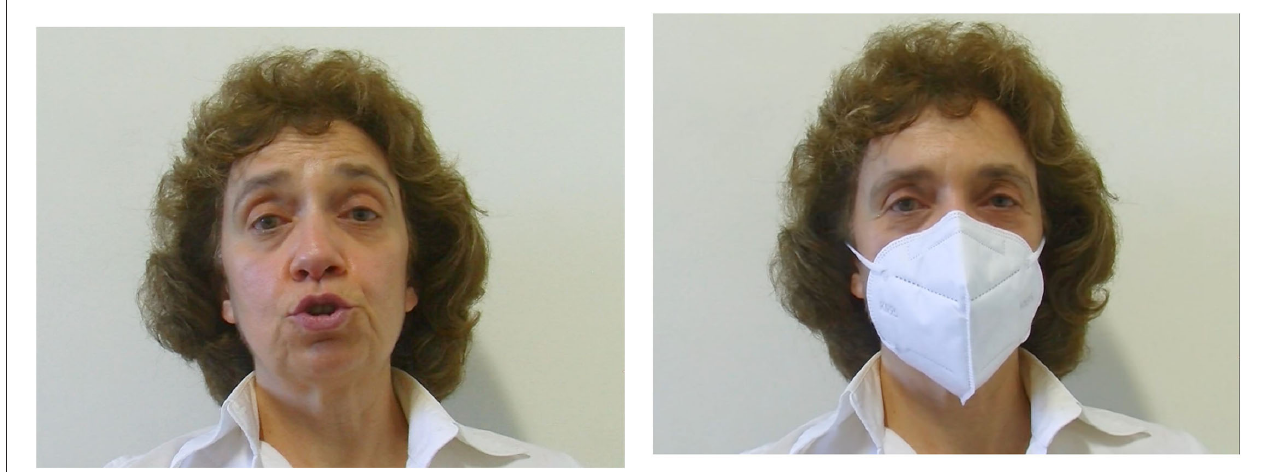
FIGURE 5 | An example frame from audiovisual stimuli for the without- and with-mask conditions.